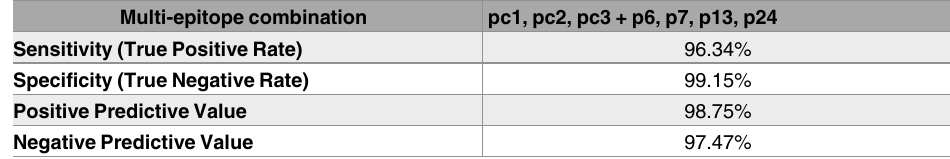
Table 3. Summary of performance of the final multiepitope